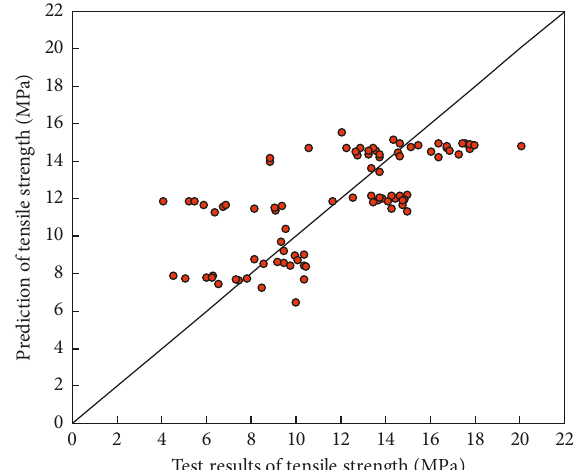
Figure 10: Comparison of the test results and prediction of the tensile strength.